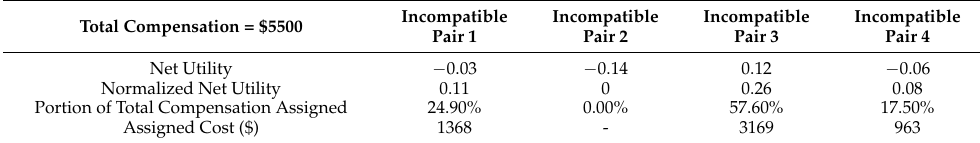
Table 5. Results of cost-apportionment process in scenario